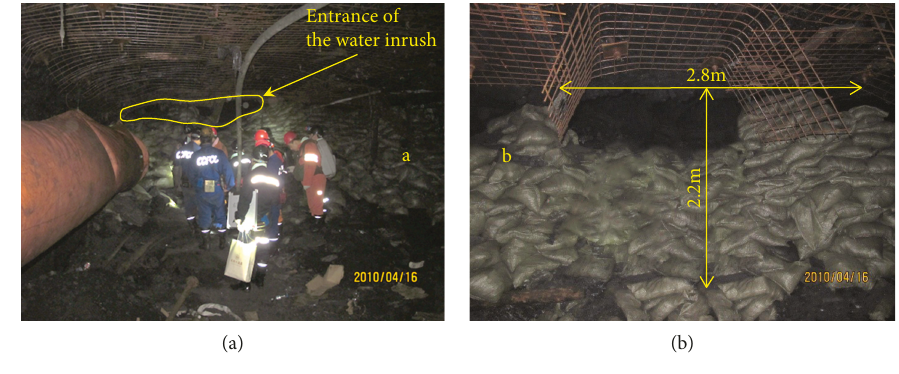
Figure 5: Location of the inrush water